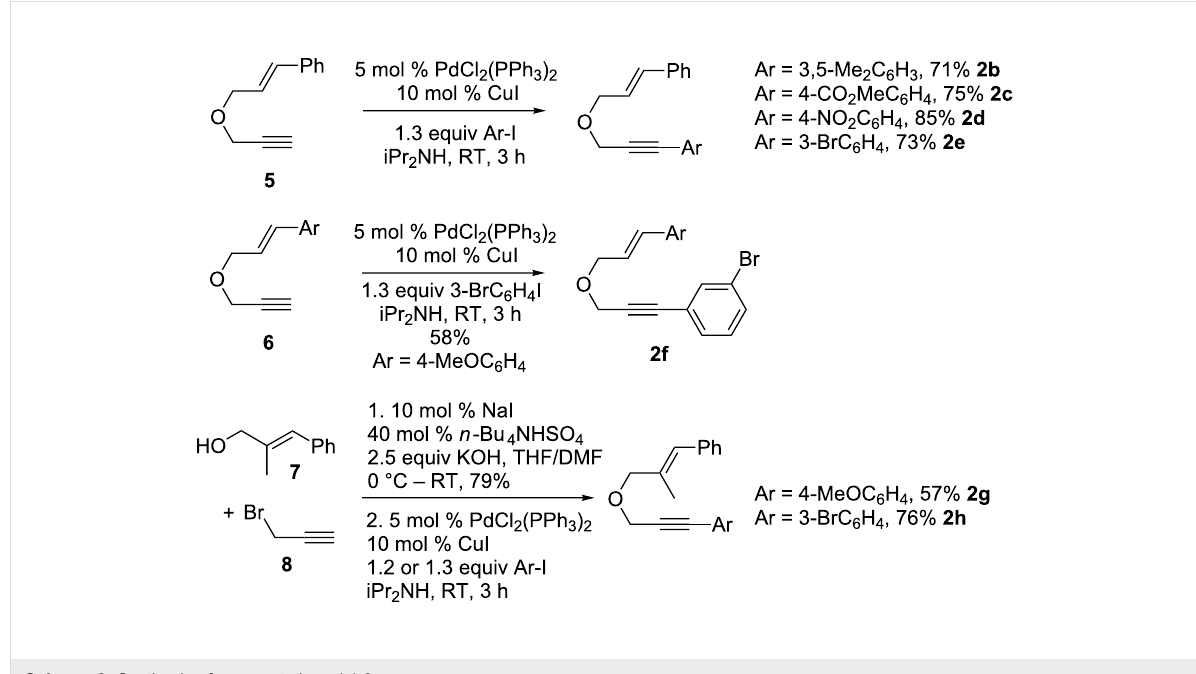
Scheme 2: Synthesis of oxygen-tethered